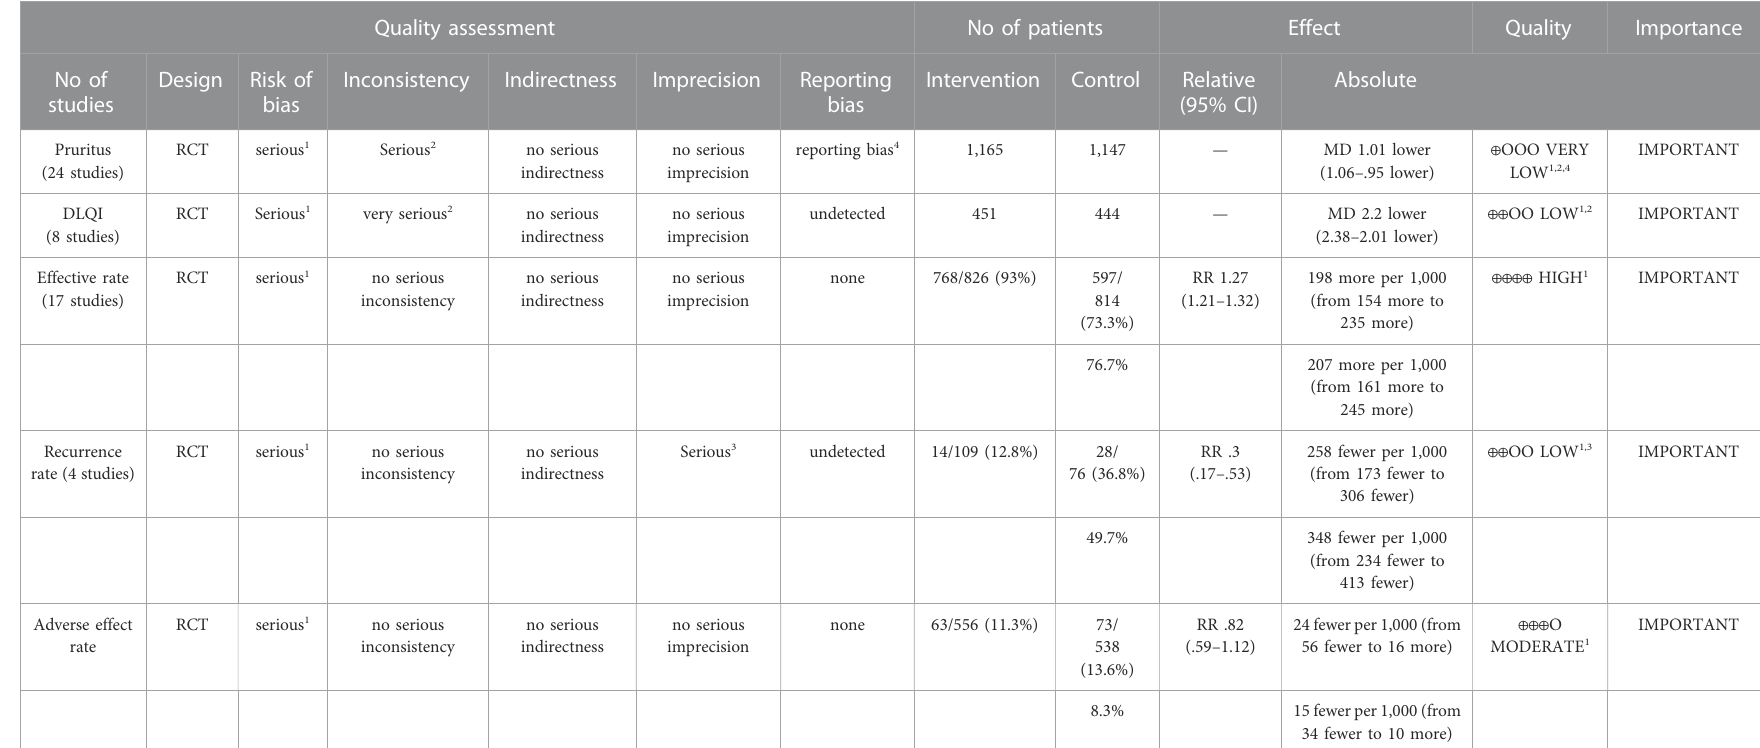
TABLE 4 Summary of